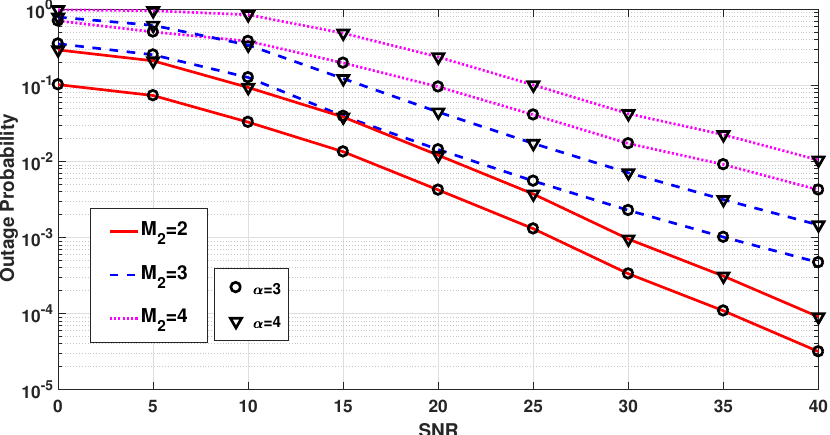
Figure 4. Impact of M 2 and α on the outage probability of the proposed Q-CNOMA